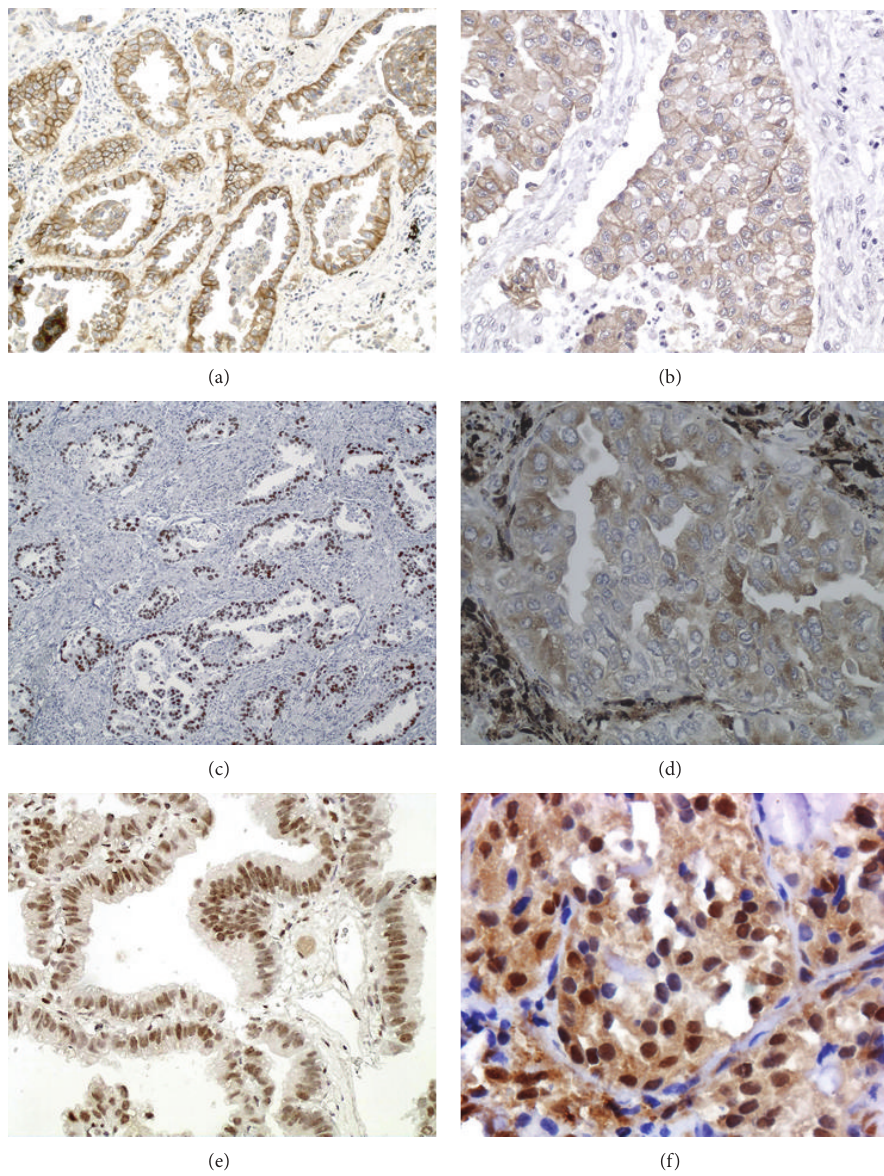
Figure 2: Immunohistochemical findings of different markers in lung adenocarcinomas. (a) EGFR positive acinar predominant tumor showingbothdistinctmembranousandcytoplasmexpression.(b)HighpowerofEGFRpositivesolidpredominantadenocarcinoma.(c)TTF- 1 positive acinar tumor. (d) High power of STAT3 positive tumor with intense cytoplasm positivity. (e) ERCC1 positive lepidic predominant tumor, with intense nuclear positivity. (f) ERK1/2 expression in solid tumor showing both nuclear and cytoplasm